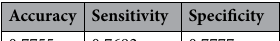
Accuracy Sensitivity